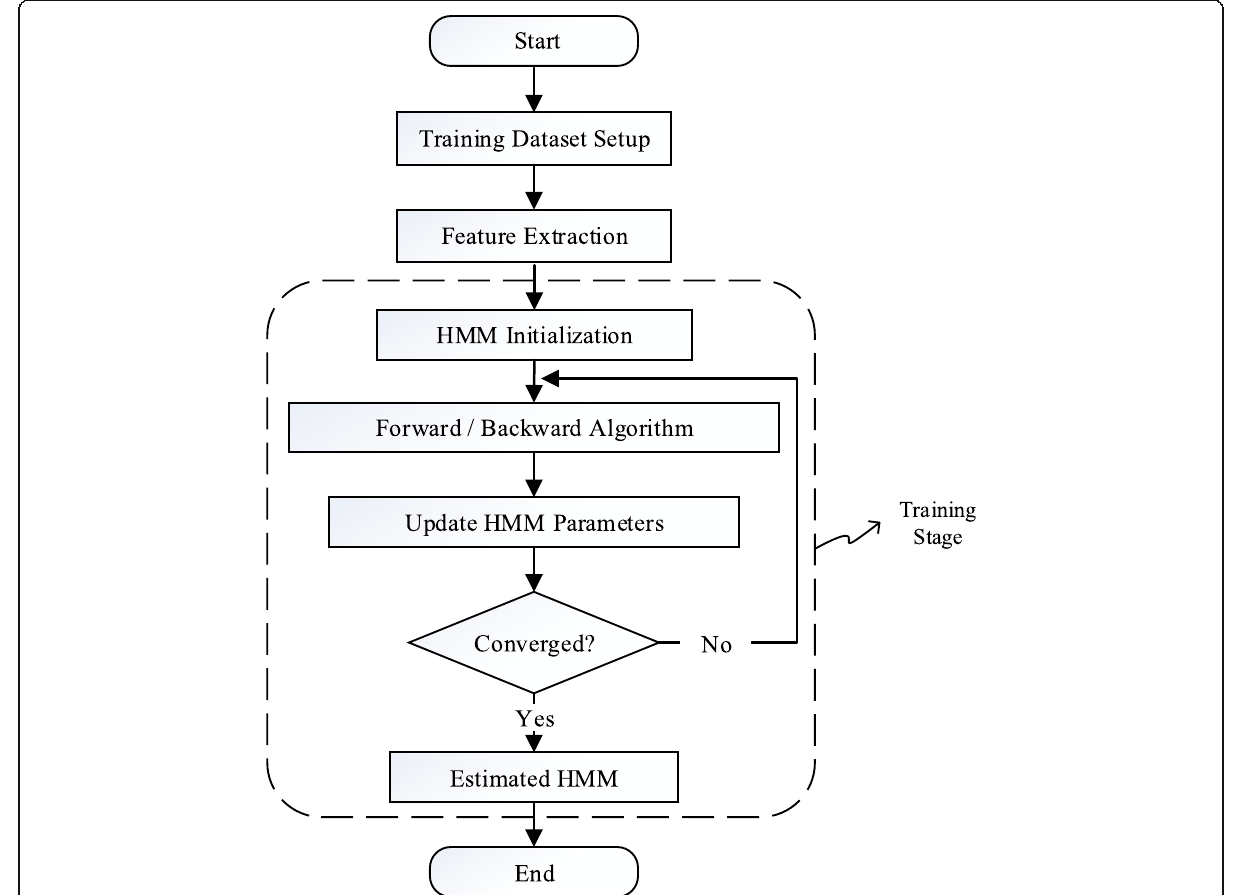
Fig. 13 Flowchart of the training procedure in the